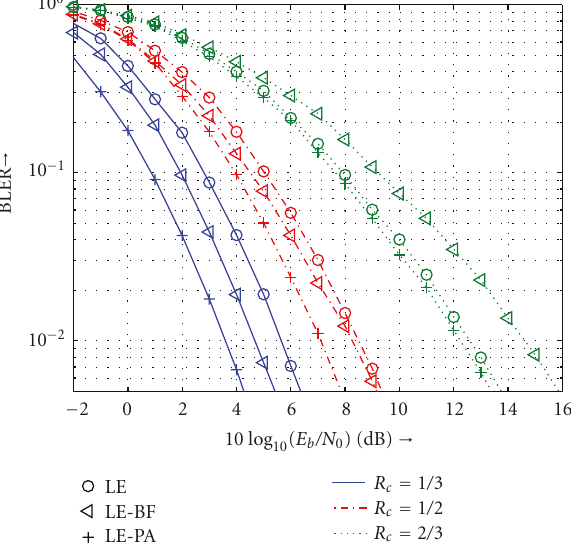
Figure 4: BLER for linear MMSE equalization (LE), LE with beam- forming (LE-BF), and LE with beamforming and power allocation (LE-PA) for Pedestrian A channel.